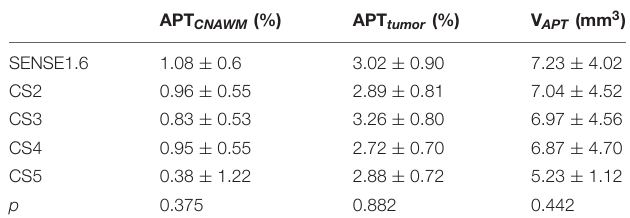
TABLE 4 | Comparisons of quantitative APT values for metastasis among CS-SENSE and SENSE scans.